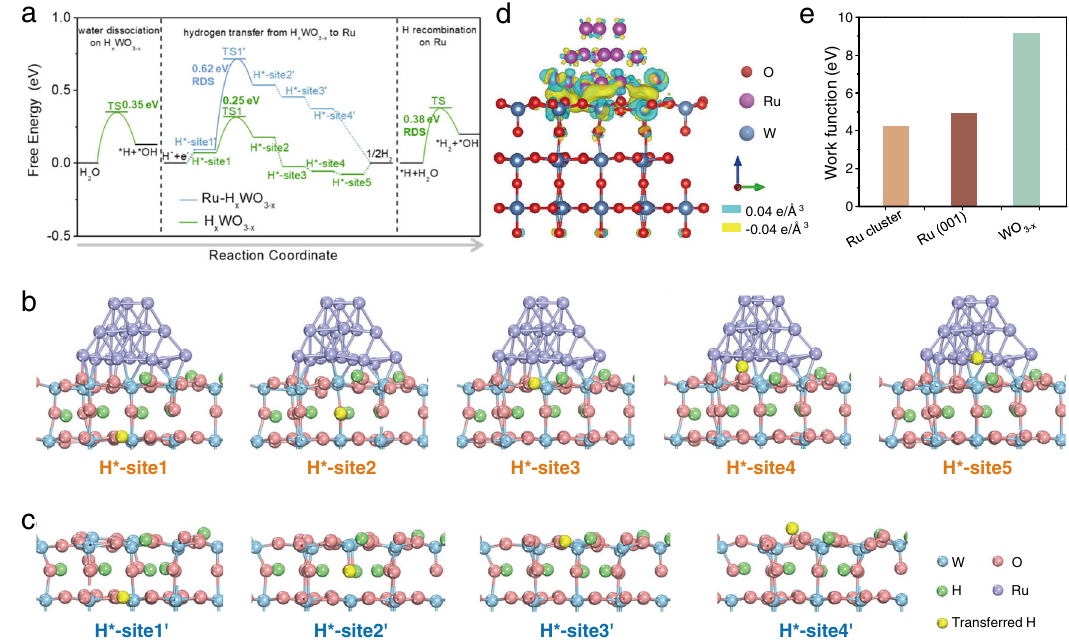
Fig. 5 | DFT calculations of hydrogen transfer energy barrier. a Calculated free energy diagram for HER on Ru-H x WO 3 − x and H x WO 3 − x . b The optimized H* adsorption structure on various sites of Ru-H x WO 3 − x . c The optimized H* adsorption structure on various sites of H x WO 3 − x . d Electron density difference